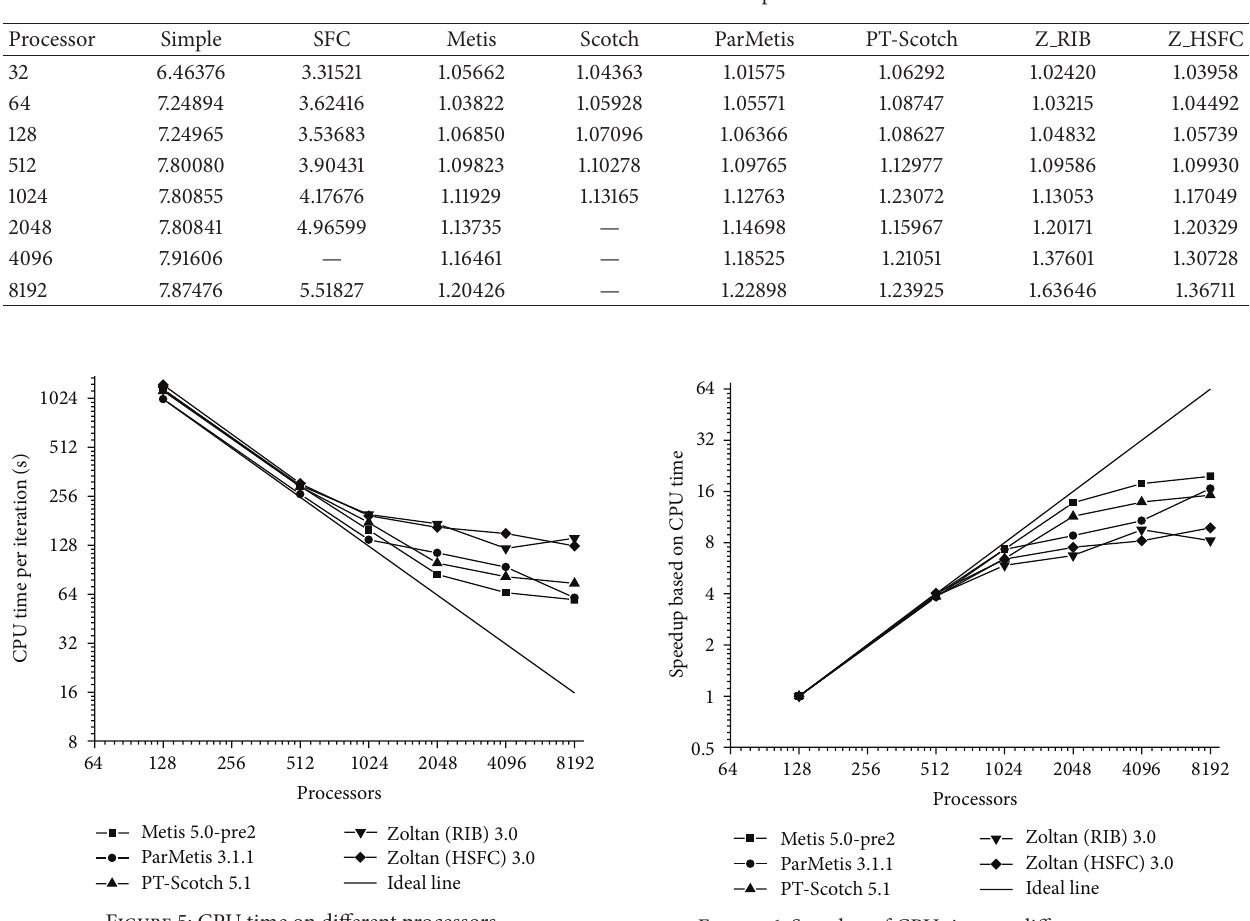
Figure 5: CPU time on different processors. Figure 6: Speedup of CPU time on different